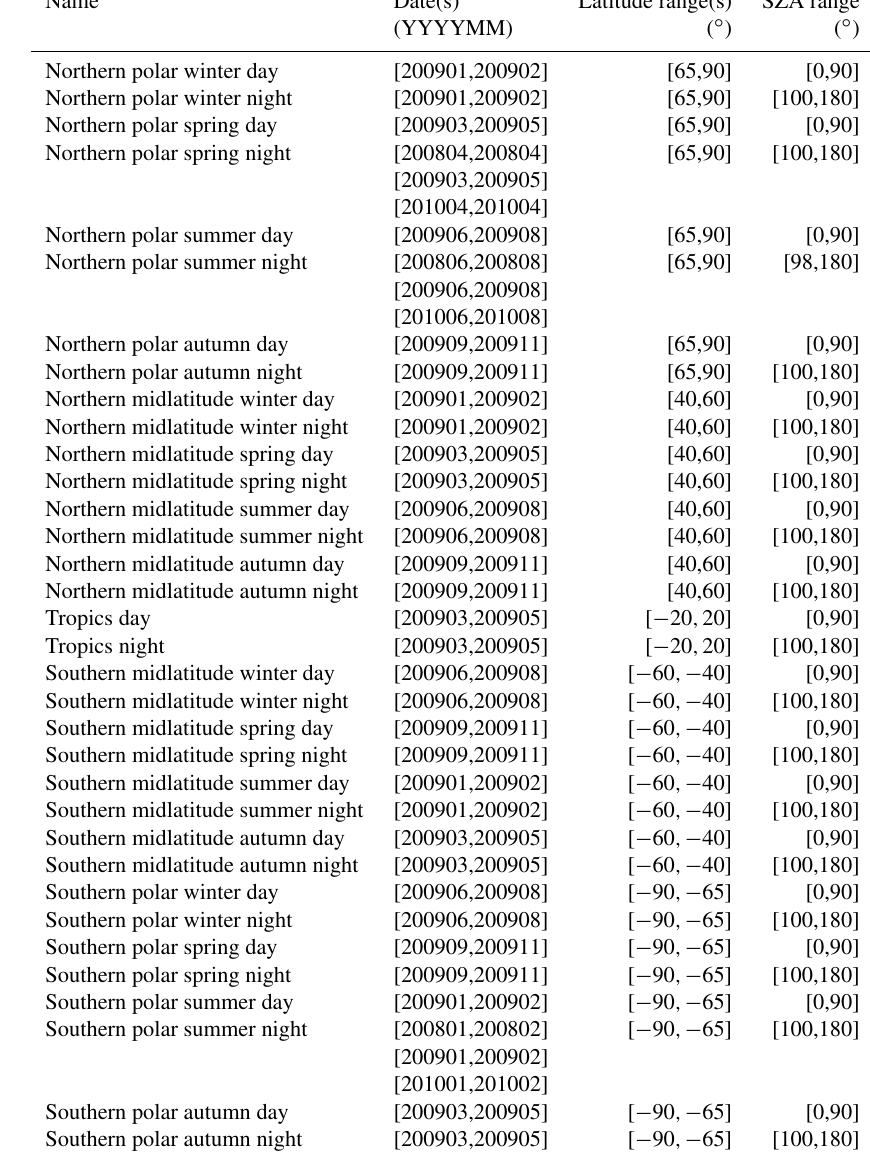
Table A4. Measurements used for error analysis of upper atmosphere measurements and low solar